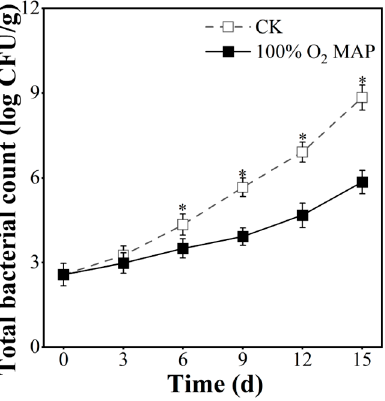
Figure 4. Effect of 100% O 2 MAP on total bacterial count of fresh-cut broccoli. * in the figure indicates significant differences among treatments at the same storage time ( p <